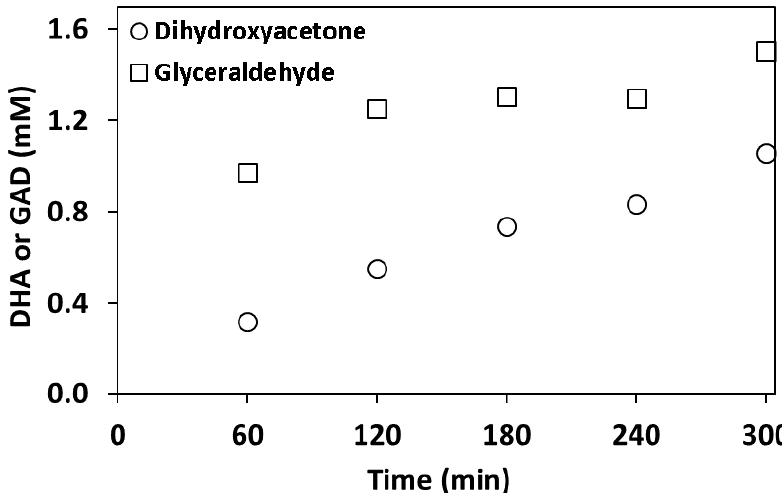
Figure 5. Photocatalytic reaction of crude glycerol in ethyl acetate and water under simulated solar light. Water: 10 mL, ethyl acetate: 90 mL, crude glycerol: 0.0622 g (~0.36 mmol of glycerol), Degussa P25 TiO 2 : 0.1 g.